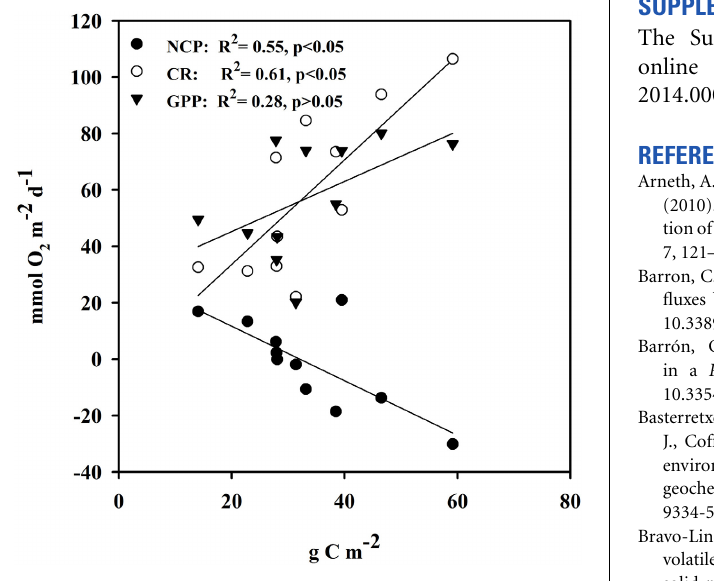
FIGURE 6 | Linear relationship of metabolic rates vs. Caulerpa prolifera biomass from the cores used in the estimation of metabolic rates. Closed circles represent NCP vs. C. prolifera , open circles represent CR vs. C. prolifera and closed triangles represent GPP vs. C. prolifera